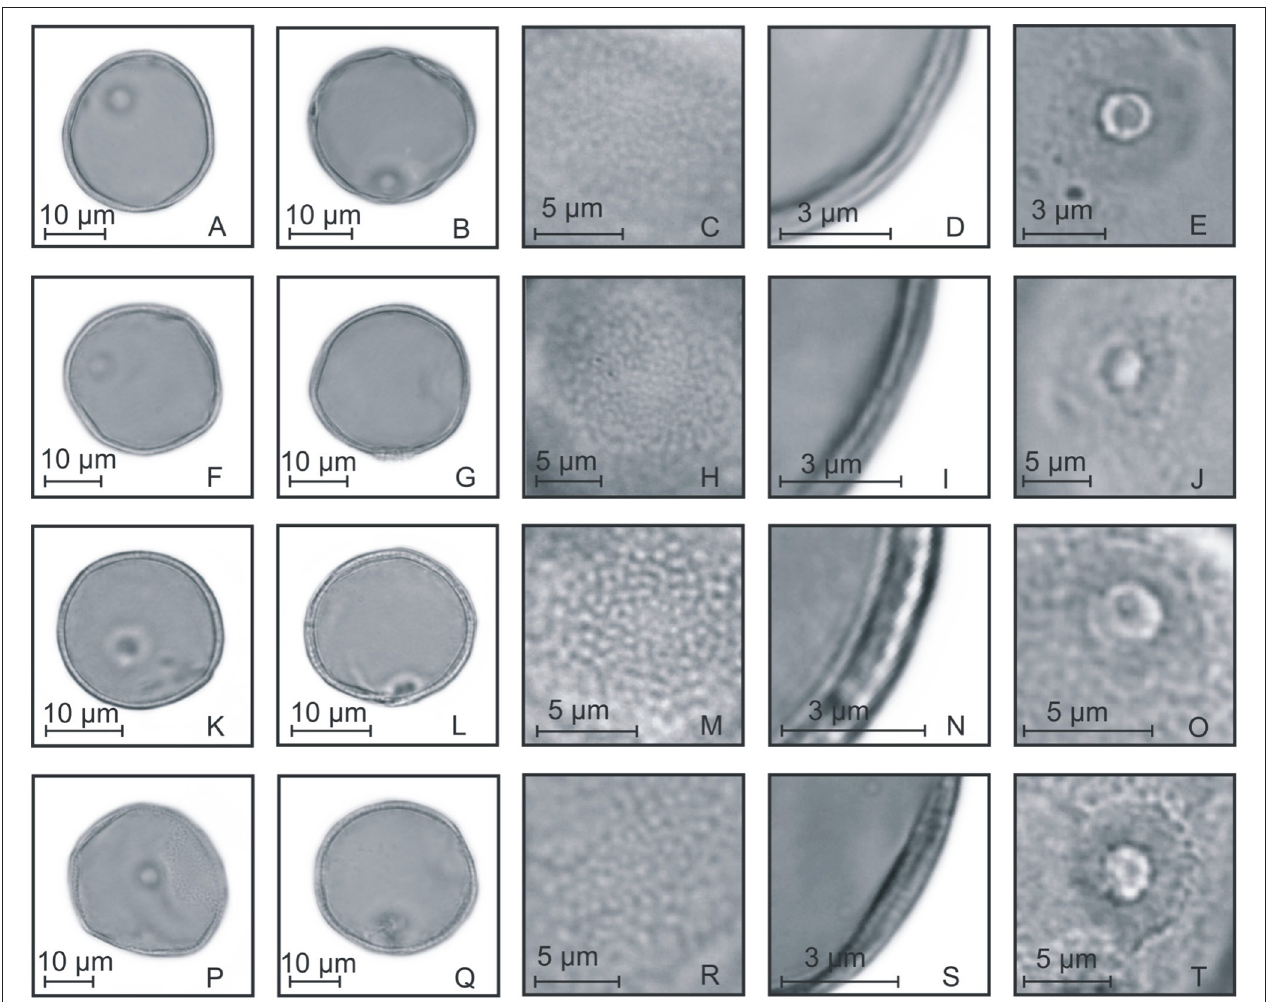
FIGURE 5 | Pollen grains of the subfamilies Ehrarthoideae, Danthonioideae, and Chloridoideae. (A–E) Leersia sp.: PV (A) , EV (B) , detail of ornamentation (C) , detail of the thickness of the exine (D) , and detail of the aperture (E) ; (F–J) Danthonia montana : PV (F) , EV (G) , detail of ornamentation (H) , detail of the thickness of the exine (I) , and detail of the aperture (J) ; (K–O) Eragrostis neesii : PV (K) , EV (L) , detail of ornamentation (M) , detail of the thickness of the exine (N) , and detail of the aperture (O) ; (P–T) Chloris canterae : PV (P) , EV (Q) , detail of ornamentation (R) , detail of the thickness of the exine (S) , and detail of the aperture (T)